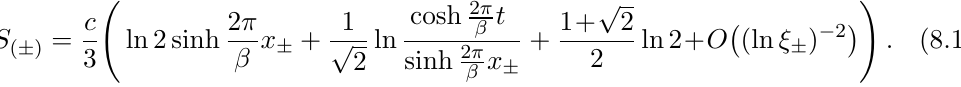
Figure 13 . The 3d bulk picture of constant (cid:28) slice is given for (cid:24) I (cid:12)gure, we choose the case x + > x (cid:0) for the sake of illustration. The dotted red lines represent